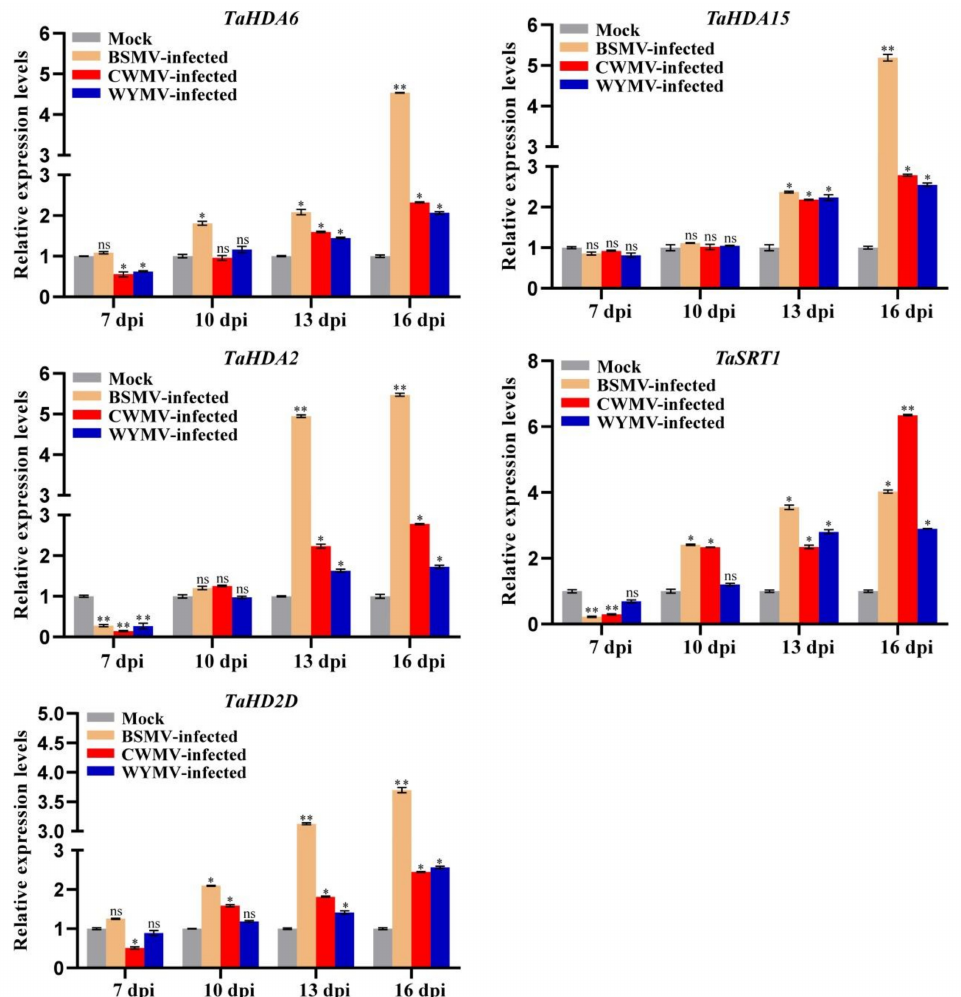
Figure 8. RT-qPCR results of the expression level of representative TaHDAC genes following inoculation of wheat plants with different viruses. The relative expression levels were calculated from 3 independent biological replicates using the 2 − ∆∆ C(t) method. TaCDC was used as internal control. Statistical analyses were performed using the Student’s t -test. *, p < 0.05; **, p < 0.01; ns, no significant